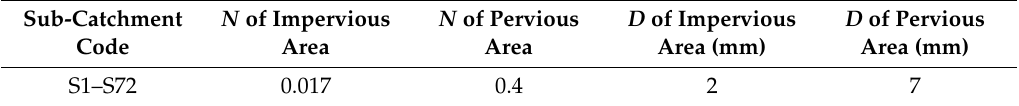
Table 2. Initial values of sensitive parameters.